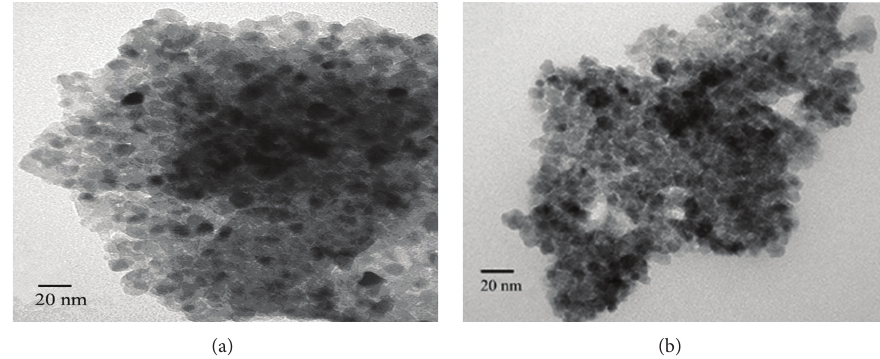
Figure 2: TEM micrograph of (a) TiO 2 and (b) ZnS-Bi-TiO 2 -0.005.